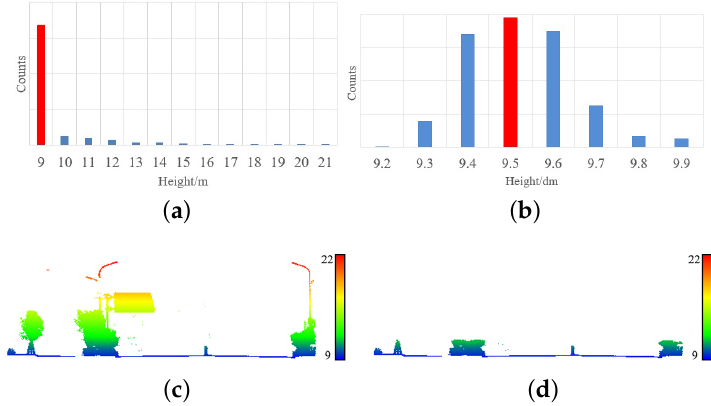
Figure 4. Preprocessing based on elevation. ( a ) First, an elevation histogram in meters is plotted, and the pavement elevation is 9 m. ( b ) Then, a further elevation histogram in decimeters is plotted, and the pavement elevation is 9.5 m. ( c , d ) The point cloud before and after elevation-based